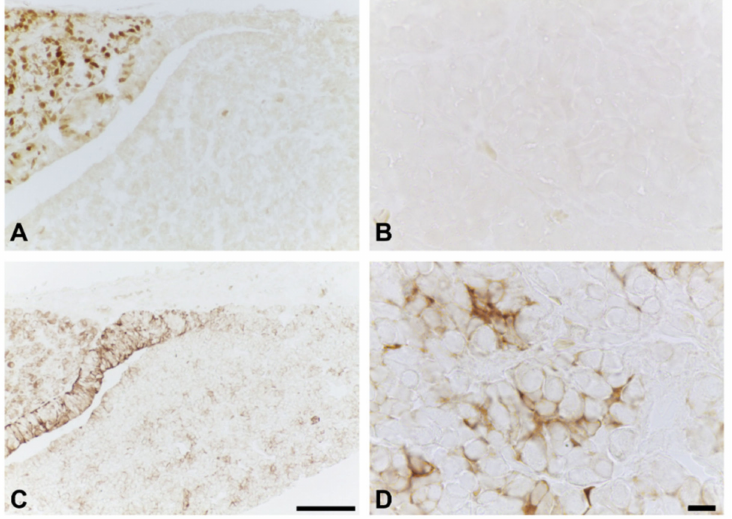
Figure 2. Immunohistochemistry of S100 (( A , B ): higher magnification view of ( A )) and aldolase C (( C , D ): higher magnification view of ( C )) on postnatal Day 1 in the anterior pituitary glands of control rats. Scale bars: 100 µ m ( A , C ); 10 µ m ( B , D